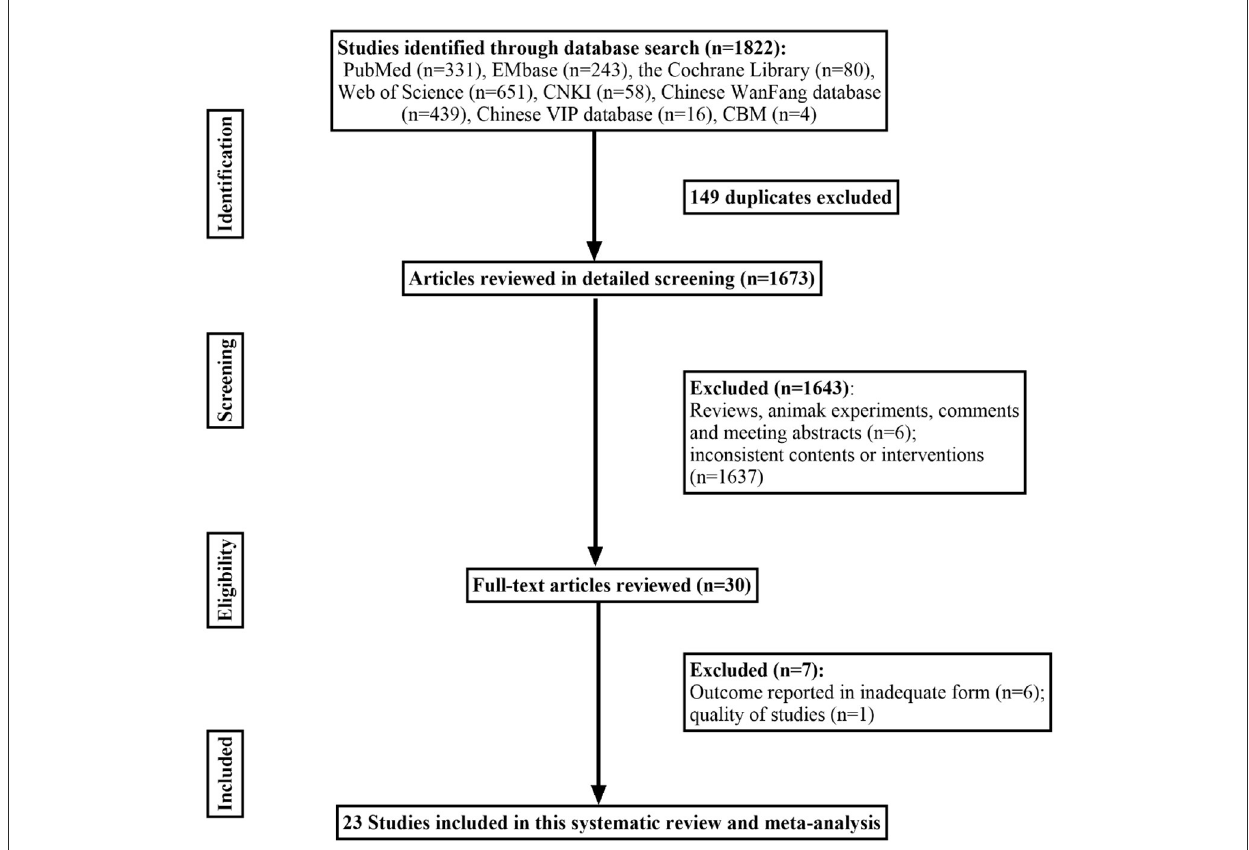
FIGURE1 Flow chart of studies